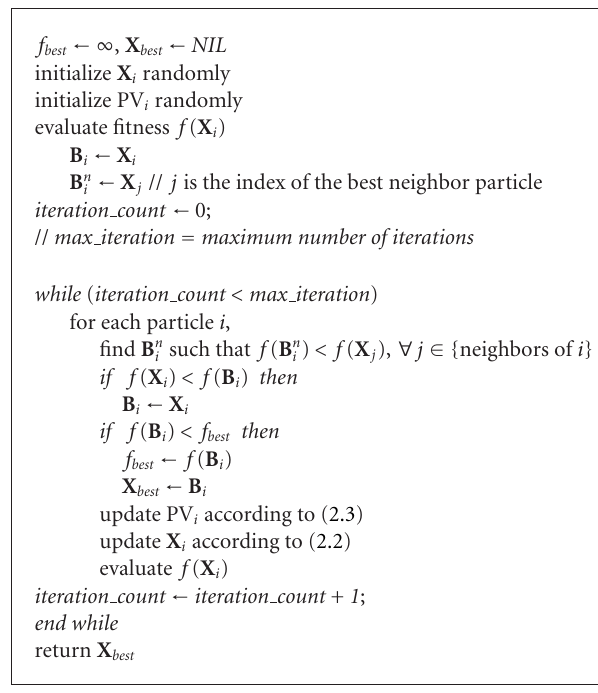
Algorithm 2 . 1 . Simple particle swarm optimization algorithm (with